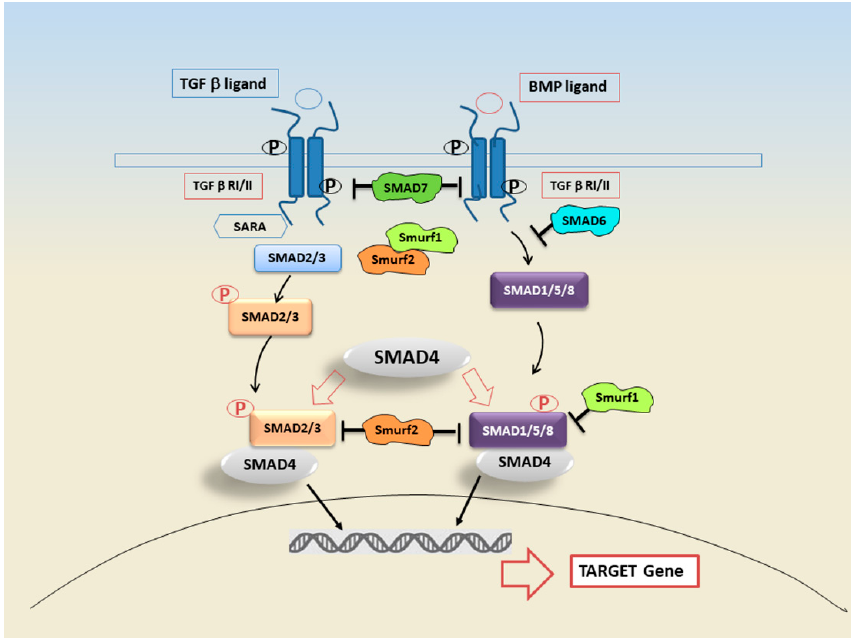
Figure 1. TGF- β signalling is triggered through BMP or TGF- β ligands. Ligands bind the TGF- β receptor II (TGF- β R-II) which recruits and phosphorylates TGF- β receptor I (TGF- β R-I). In the TGF- β signalling pathway, TGF- β R-I phosphorylates the SMAD2 and 3, or SMAD1, 5, and 8.